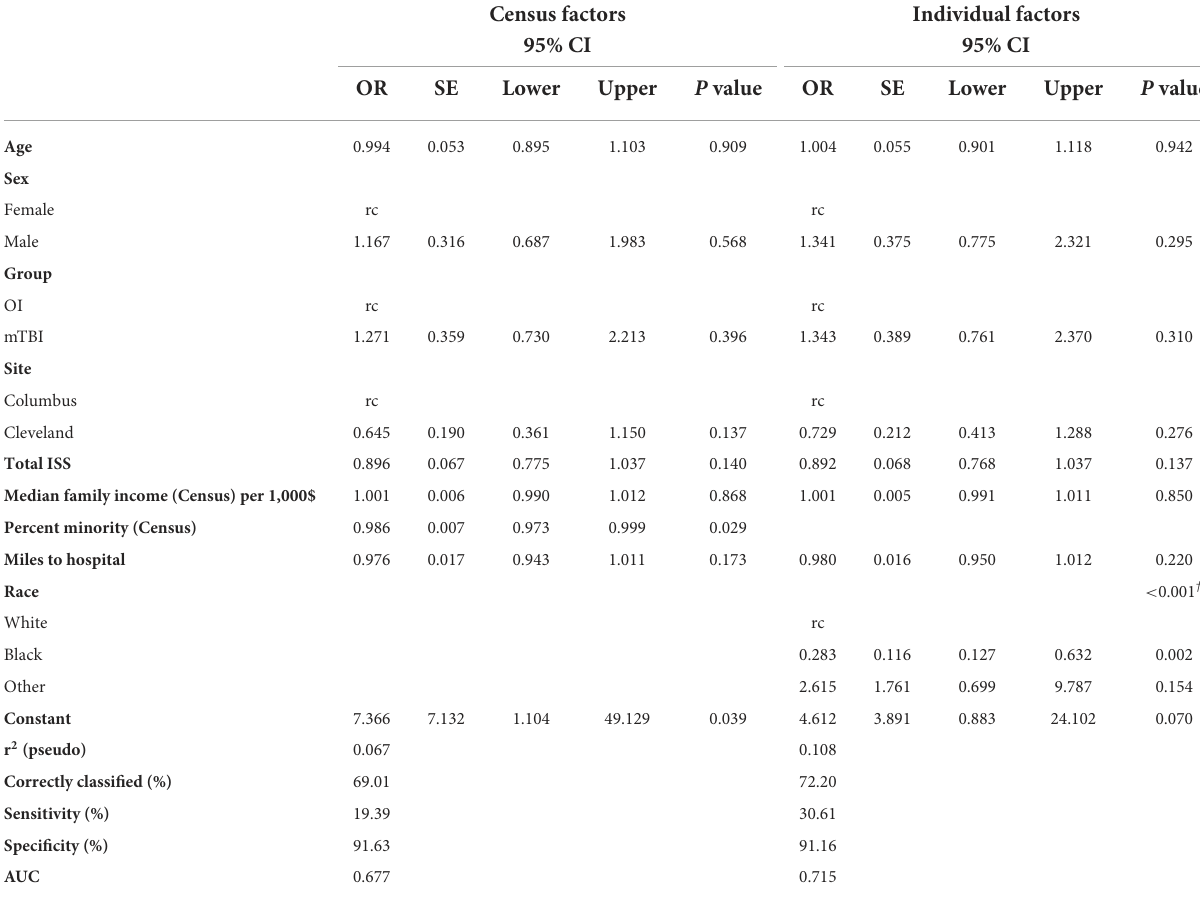
TABLE 4 Multivariable model–odds of consented participants returning for post-acute visit.